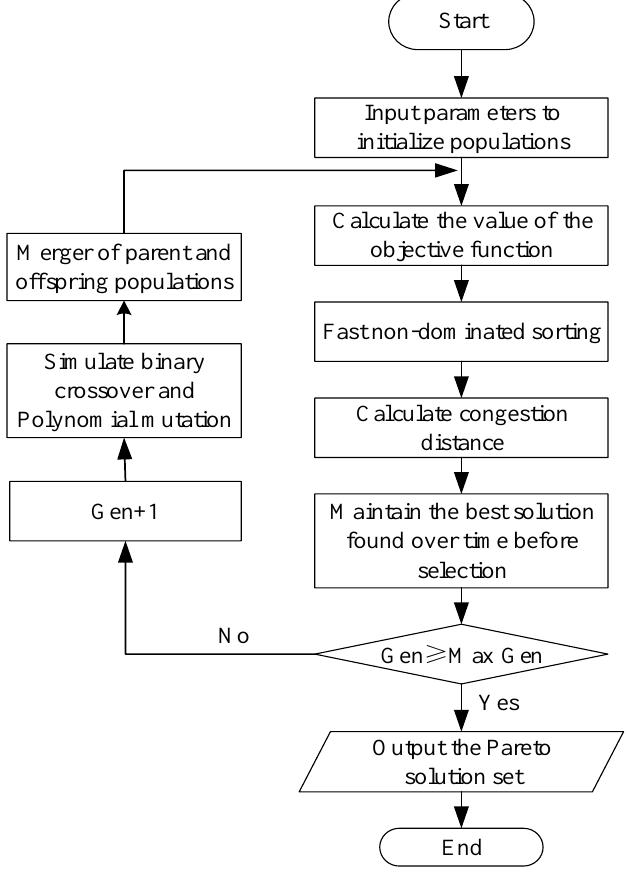
Figure 4. NSGAII algorithm processes.